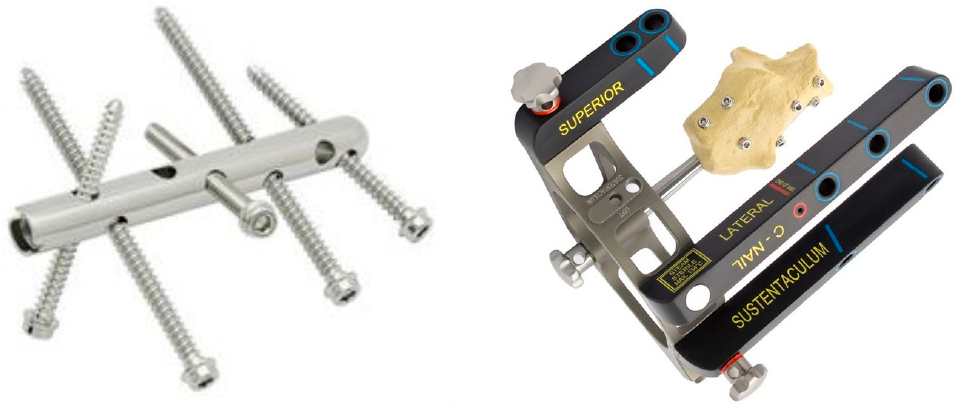
Figure 5. Internal fixator C-NAIL for treatment of the heel bone fractures and the targeting